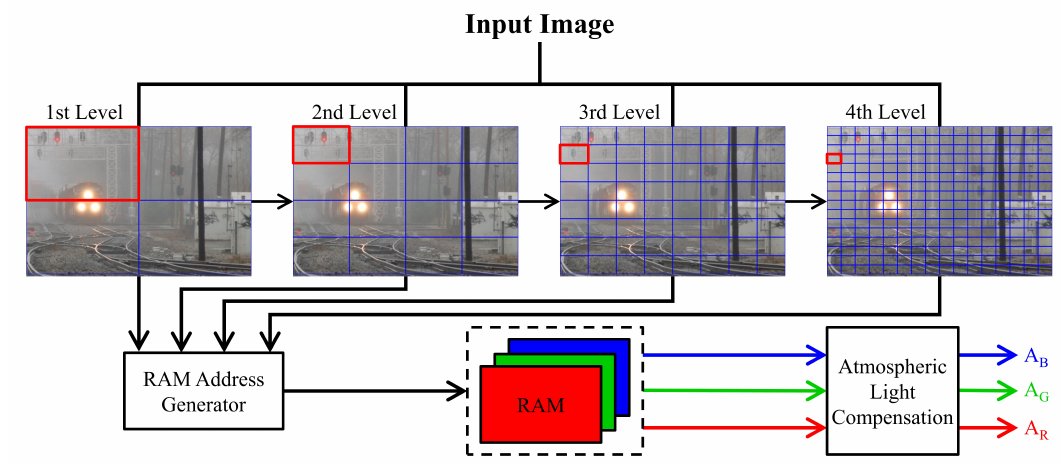
Figure 5. Parallel computing scheme for atmospheric light estimation and compensation.